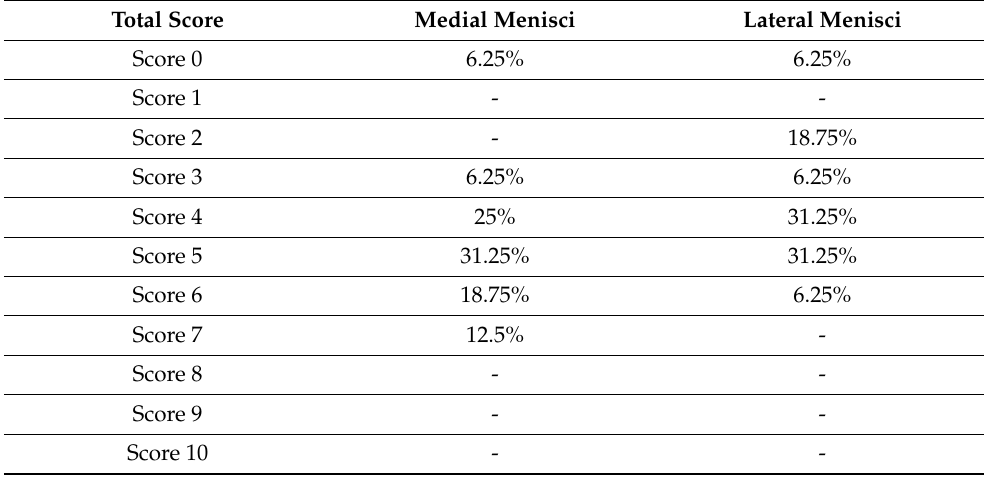
Table 3. Percentage distribution of total histological score for medial and lateral menisci.